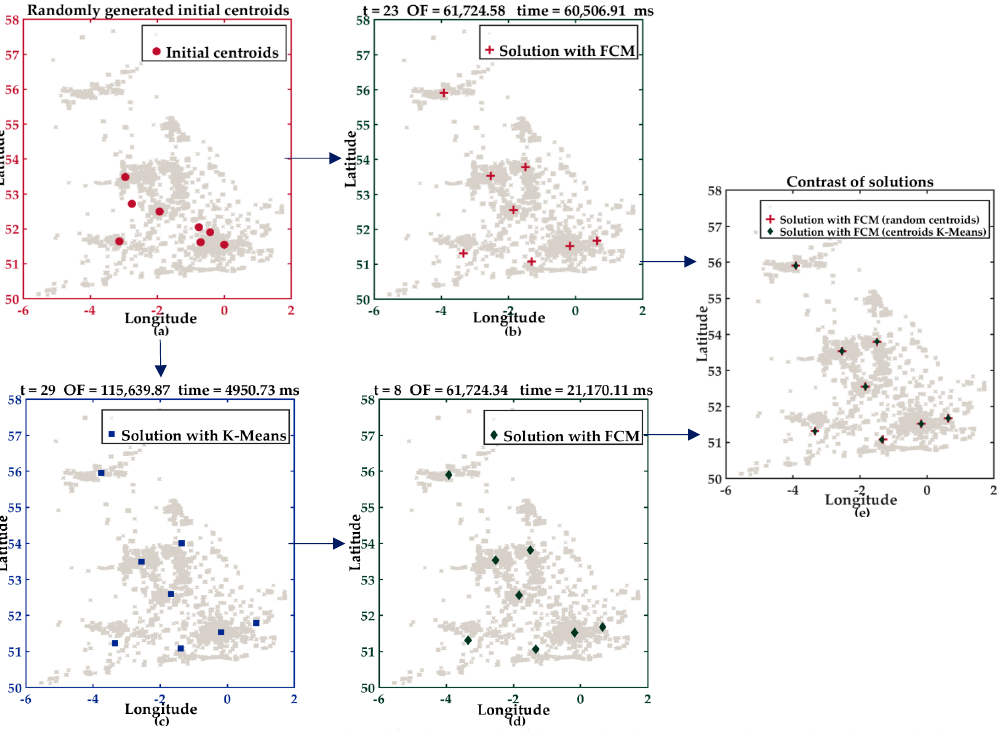
Figure 1. Initial and final centroids of the standard K-Means and FCM algorithms with the URBAN dataset in Example 1. Panel ( a ) shows the randomly generated initial centroids; ( b ) contains the final centroids with the solution of the standard FCM algorithm, considering the random initial centroids; ( c ) displays the final centroids of the K-Means algorithm receiving random centroids; ( d ) displays the final centroids of FCM with initial centroids generated after the convergence of K-Means; and ( e ) presents a comparison of the solutions of the FCM algorithm, whose initial cen- troids are random and generated by